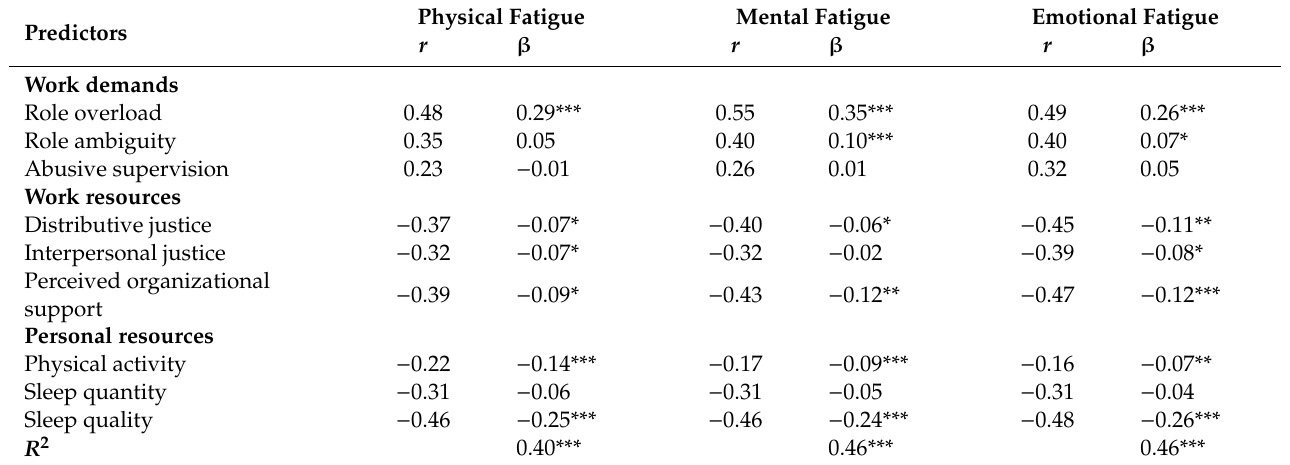
Table 4. Regression of Work Fatigue on Predictor